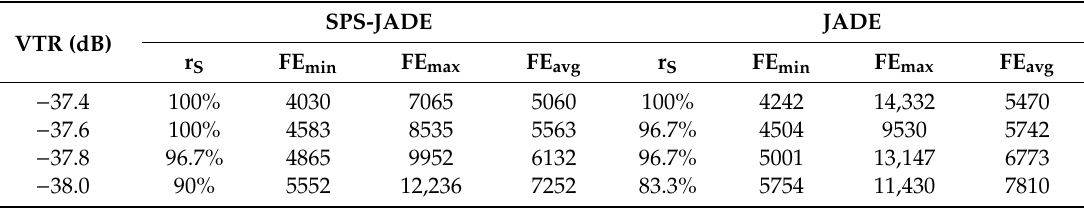
Table 3. Results of the pattern synthesis e ffi ciency test with sidelobe